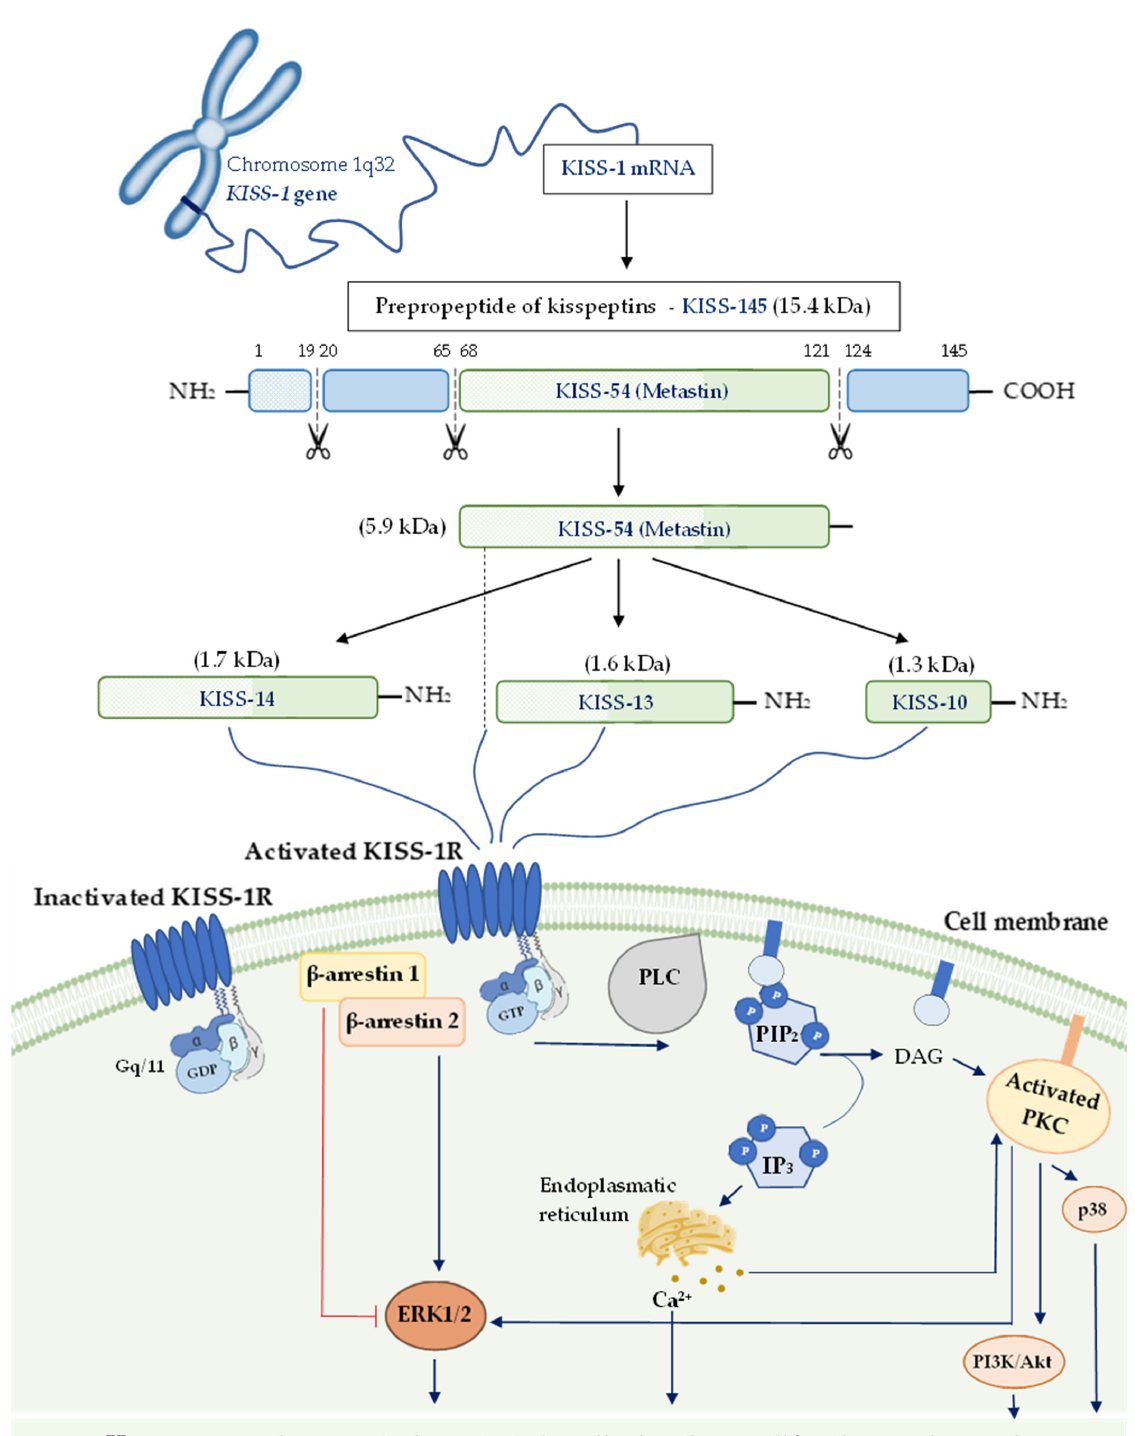
Figure 1. The process of kisspeptin isoforms formation and their putative signaling pathways. The activation pathways are shown as blue lines and inactivation ones in red. Abbreviations: KISS-1 gene— kisspeptin gene; KISS-145—kisspeptin-145; KISS-54—kisspeptin-54; KISS-14—kisspeptin-14 KISS- 13—kisspeptin-13; KISS-10—kisspeptin-10; KISS-1R—KISS-1 receptor; PLC—phospholipase C; PIP 2 — phospatidylinoinositol-4,5-diphosphate; DAG—diacylglycerol; IP 3 —inositol-(1,4,5)-triphosphate; PKC—protein kinase C; PI3K/Akt—phosphatidylinositol 3-kinase/Akt; ERK—extracellular signal- regulated